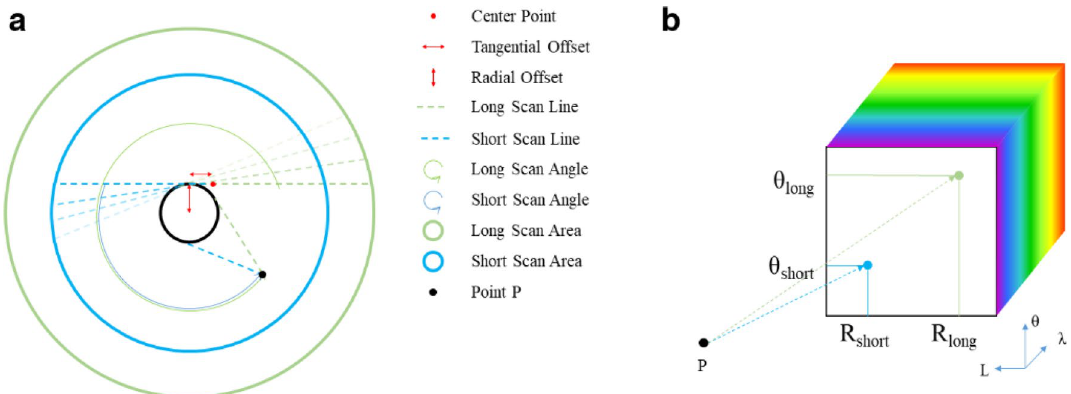
Figure 2. ( a ) Scanning with the rotational image line; ( b ) map to hyperspectral data (even at the outmost edge), the rotational angle at each step of frame should be less than the angel of the arc. In the experiment, we usually set the motion increment to 1°. Hence the spatial resolution is not restricted by the motion step, but determined by the slit width. Different from push-broom scanning system, our rotational hyperspectral scanner rotates along the primary optical axis when working. The whole system, from the very front image lens to the camera, rotates one cycle to acquire an entire image of the object. During the rotation process, the direction of the slit varied, and the spectral images were captured synchronously. Spatial rotational image reconstruction algorithm. Same as all other spatially scanning hyperspec- tral imaging spectrometers, each spectral image obtained corresponds to a line in the object plane. However, our rotational one has a unique arrange order. According to the mechanical rotation mentioned above, such a scan line revolved around a certain center point when the system works. As illustrated in Fig. 2a, the dashed line refers to the scan line, and it faded counterclockwise to indicate the process of scan. The scan line rotates 360° to complete one scan process, and thus we record the data cube with three dimensions of L, θ and λ, as shown in Fig. 2b. Furthermore, due to limited assembly accuracy, the center of the slit was not on the mechanical rotation axis. In terms of image formation, that means there are radial and tangential offsets between the scan line and the rotation center. Consequently, there exists a blind circle in the middle of the image. Now, it is important to design an image algorithm to reconstruct the real image of the object from the data cube and estimate the two offset distances. As illustrated by vertical and horizontal double-headed arrows in Fig. 2a, the radial and tangential offsets are denoted by R offset and L offset , respectively. Assume the length of the image line equals to 2L , then the length of the long and short scan lines are L + L offset and L − L offset , which is indicated by the green and blue dashed lines, respectively. For each point P ( R p , θ p ∈ [0, 2 π)) within the range 2 , it can be swept across by the longer scan line. Thus, we can calculate the rotation + ( L + L < R 2 R 2 offset ) p offset angle θ long and its relative location R long , when point P is scanned by the longer scan line. R long equals to the tan- gent distance of point P and blind circle, and θ long is the angle between the current scan line and the initial scan line, assuming that the scan initiates from the horizontal dashed line and rotates counterclockwise (as positive θ)